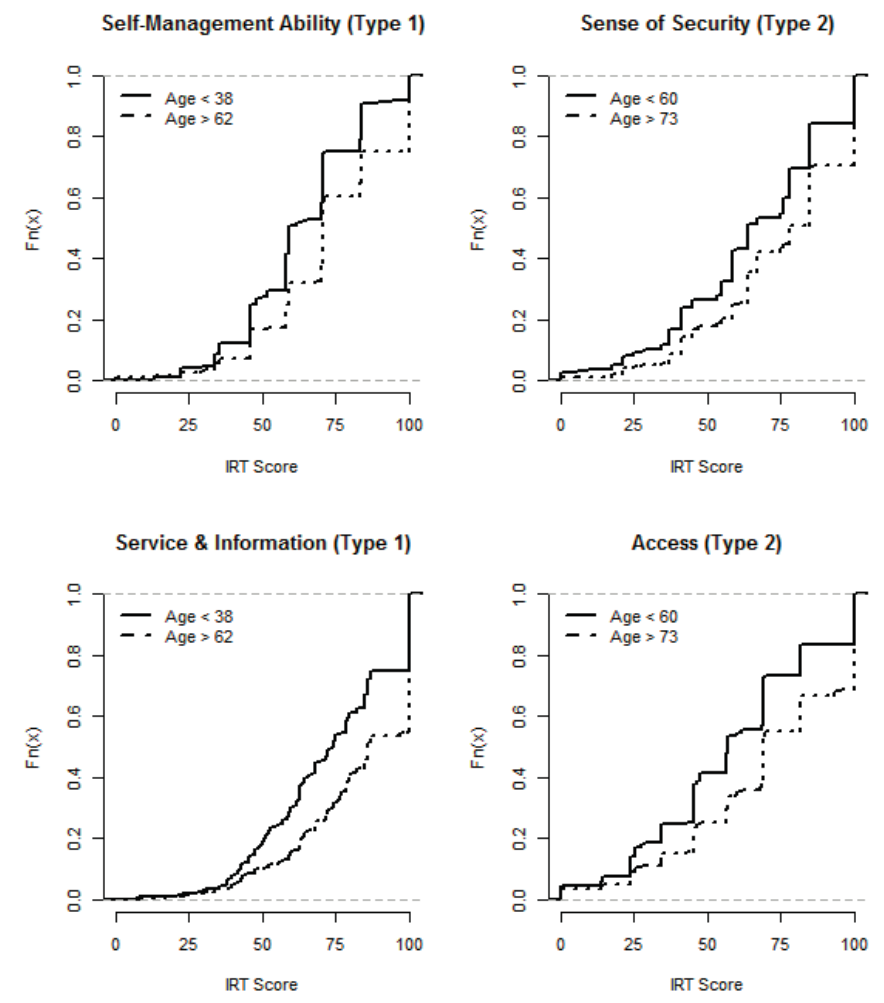
Figure 3. Empirical distribution functions: Self-Management Ability and Service & Information in type 1 diabetes, and Sense of Security and Access in type 2 diabetes, by age